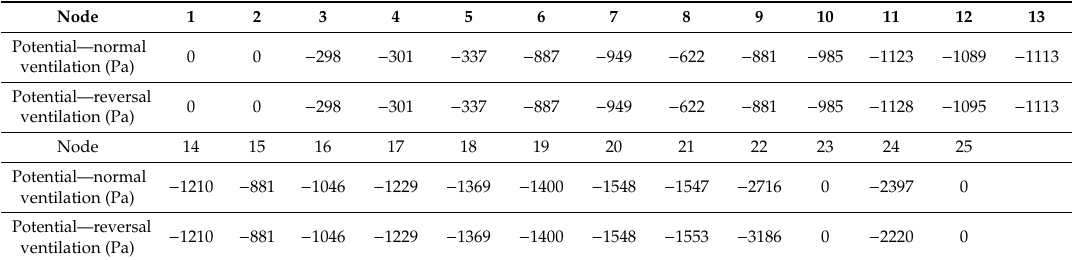
Table 5. Aerodynamic potentials in the nodes for reversal and normal venilation (own work). Node